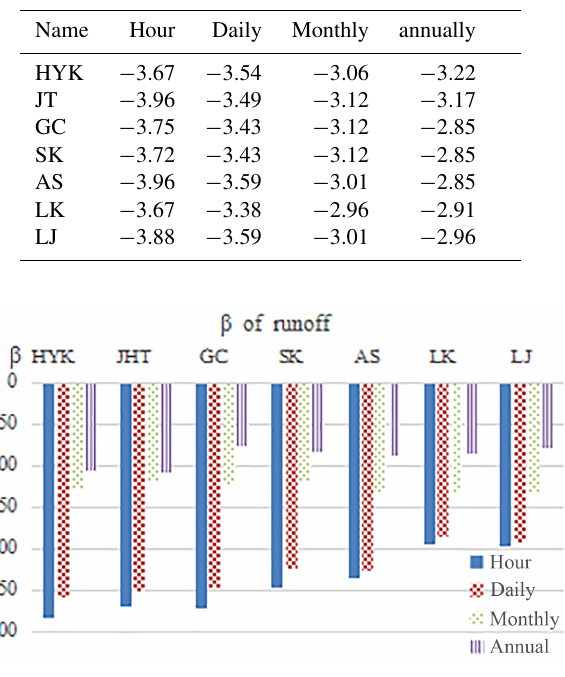
Figure 1. β of runoff in different time scale (HYK: Huayuankou; JHT: Jiahetan; GC: Gaocun; SK: Sunkou; AS: Aishan; LK: